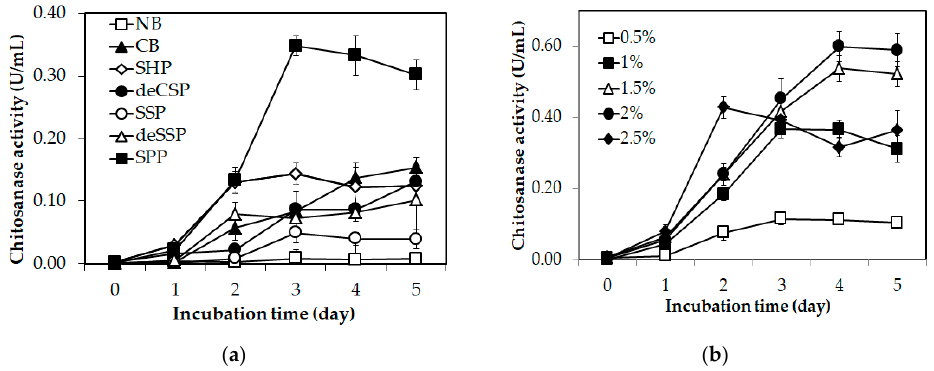
Figure 1. Screening of suitable C / N source for chitosanase production by Paenibacillus sp. TKU047: ( a ) different chitinous sources and ( b ) different concentrations of SPP. NB: nutrient broth; CP: chitin powder; SHP: shrimp heads powder; deCSP: demineralized crab shells powder; SSP: shrimp shells powder; deSSP: demineralized shrimp shells powder; and SPP: squid pens powder. All data points